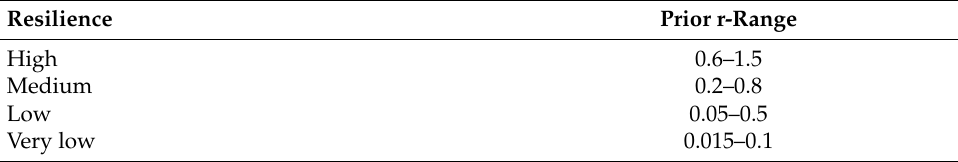
Table 1. Classification of prior ranges for resilience parameter